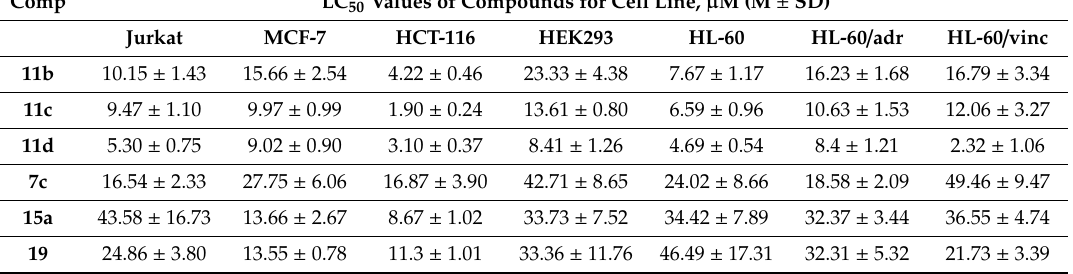
Table 2. LC 50 values of studied CK2-HDAC dual inhibitors towards human tumor and pseudonormal cell lines in vitro .